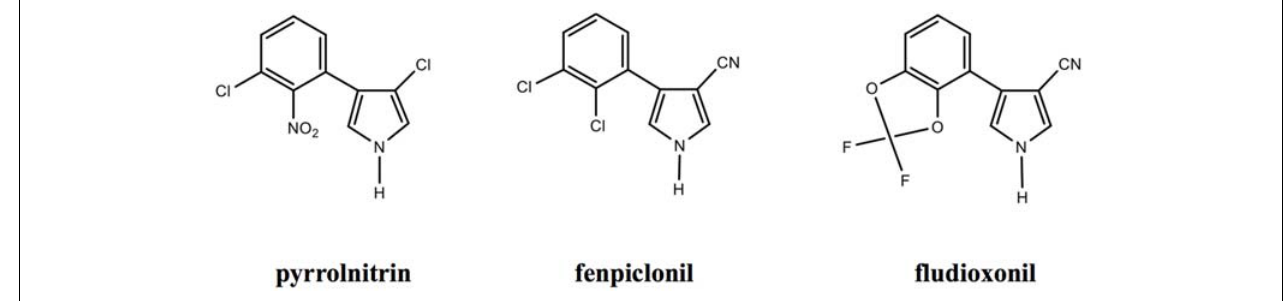
FIGURE 1 | Chemical structure of Pyrrolnitrin (Imanaka et al., 1965) and synthetic analogs (www.frac.org). The chemical characteristics of phenylpyrroles are the phenyl ring with substitutions in positions 2 and/or 3 and the pyrrole ring with substitutions at position 3 (Corran et al.,